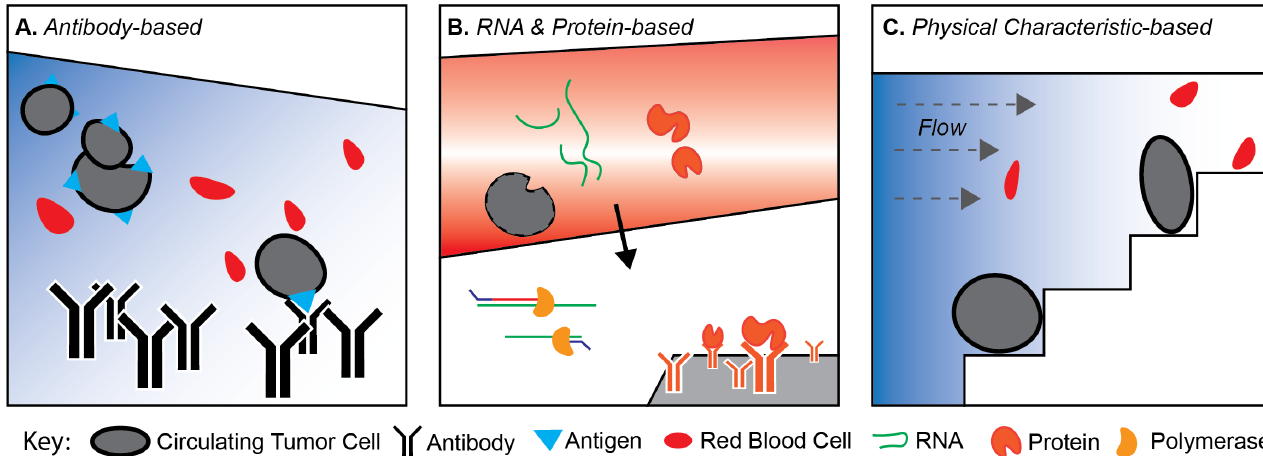
Figure 1. Platforms for circulating tumor cell isolation can be split into three main principles: ( A ) antibody-based, which utilizes antibodies to capture cell surface markers commonly expressed on circulating tumor cells (e.g., EpCAM), ( B ) RNA and protein-based, which detect the presence of CTCs based on either expressed RNA and/or secreted proteins, and ( C ) physical characteristic-based protocols, which capture CTCs from whole blood based on anticipated physical differences in CTCs and other cell populations such as red blood cells.